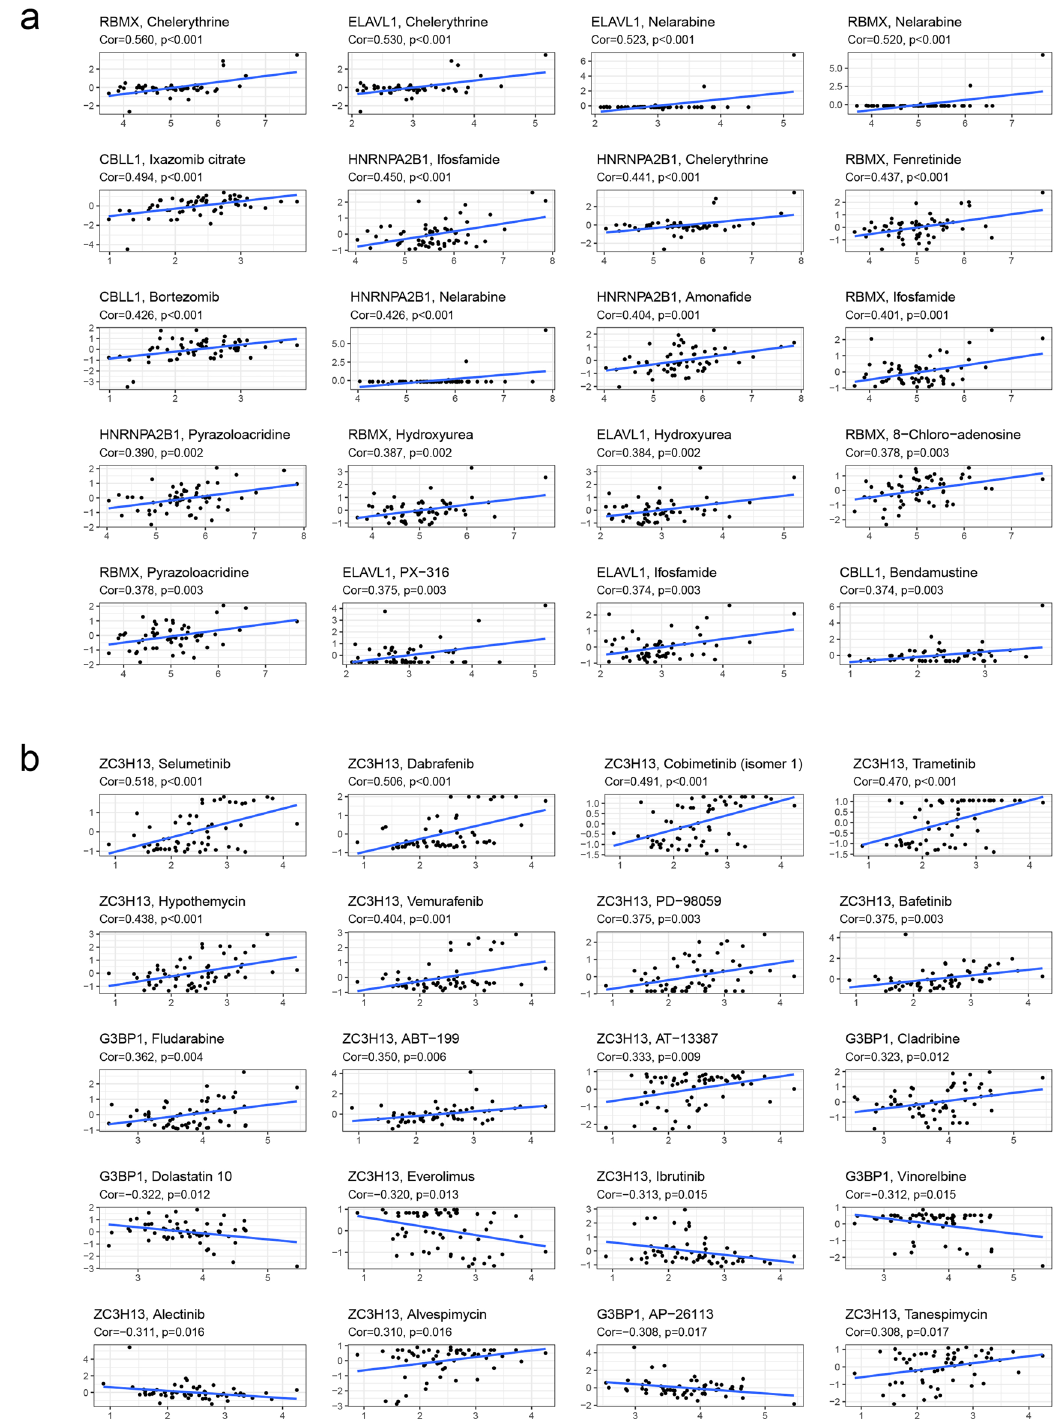
Figure 7. Analysis of treatment strategies for diagnosis and prognosis based on m 6 A regulators. ( a ) The scatter diagram showed the association between the drugs and key regulators, which might provide new clues to uncover potential mechanisms for CC diagnosis. ( b ) The association between the drugs and key prognostic